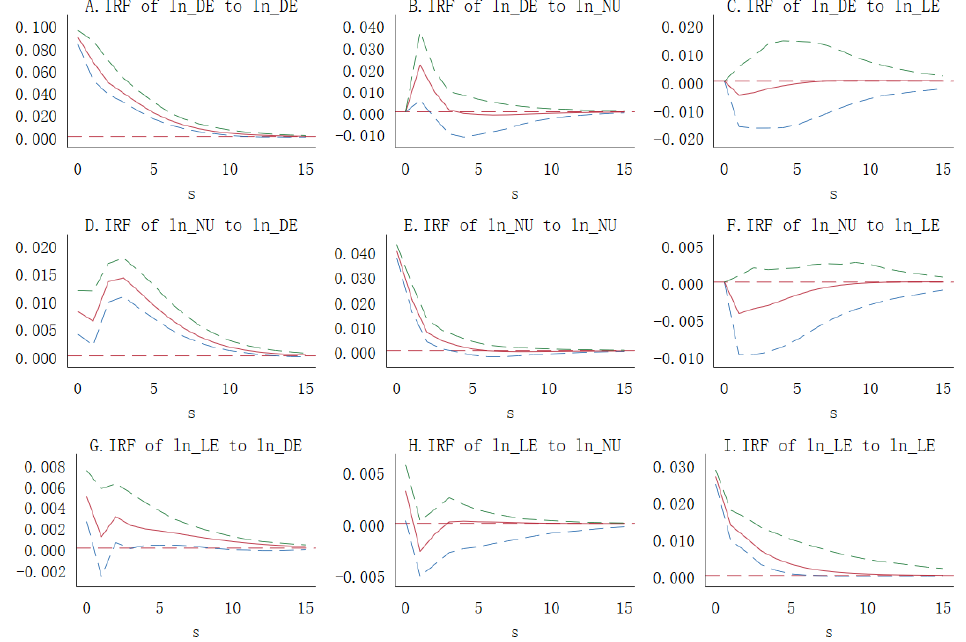
Figure 7. The impulse response analysis of DE, NU, and LE.(Subfigure A represents the impulse response of ln_DE to ln_DE. Subfigure B represents the impulse response of ln_DE to ln_NU. Sub- ln_DE to ln_DE. ( B ) represents the impulse response of ln_DE to ln_NU. ( C ) represents the impulse figure C represents the impulse response of ln_DE to ln_LE. Subfigure D represents the impulse response of ln_DE to ln_LE. ( D ) represents the impulse response of ln_NU to ln_DE. ( E ) represents response of ln_NU to ln_DE. Subfigure E represents the impulse response of ln_NU to ln_NU. Sub- the impulse response of ln_NU to ln_NU. ( F ) represents the impulse response of ln_NU to ln_LE. figure F represents the impulse response of ln_NU to ln_LE. Subfigure G represents the impulse ( G ) represents the impulse response of ln_LE to ln_DE. ( H ) represents the impulse response of ln_LE response of ln_LE to ln_DE. Subfigure H represents the impulse response of ln_LE to ln_NU. Sub- to ln_NU. ( I ) represents the impulse response of ln_LE to figure I represents the impulse response of ln_LE to ln_LE.)